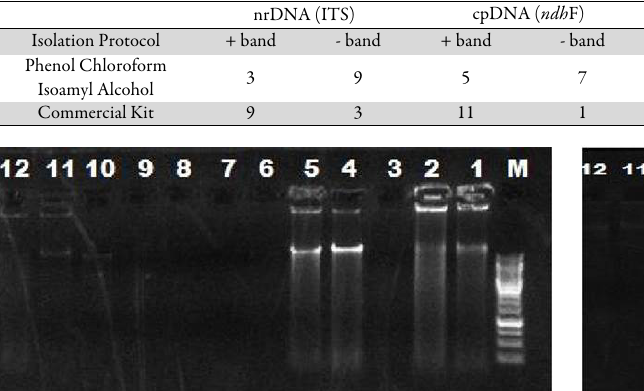
Table 3. PCR amplification results of ITS, trn L-F and ndh F primers and success rates